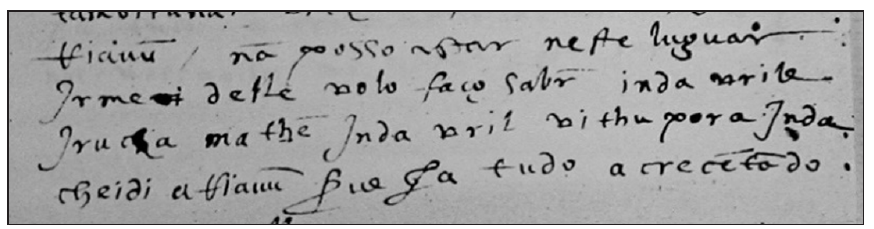
Figure 12: Extract from folio 43r in Codex 3141 (BNP, Lisbon) [containing text of example (6b), preceded & followed by other